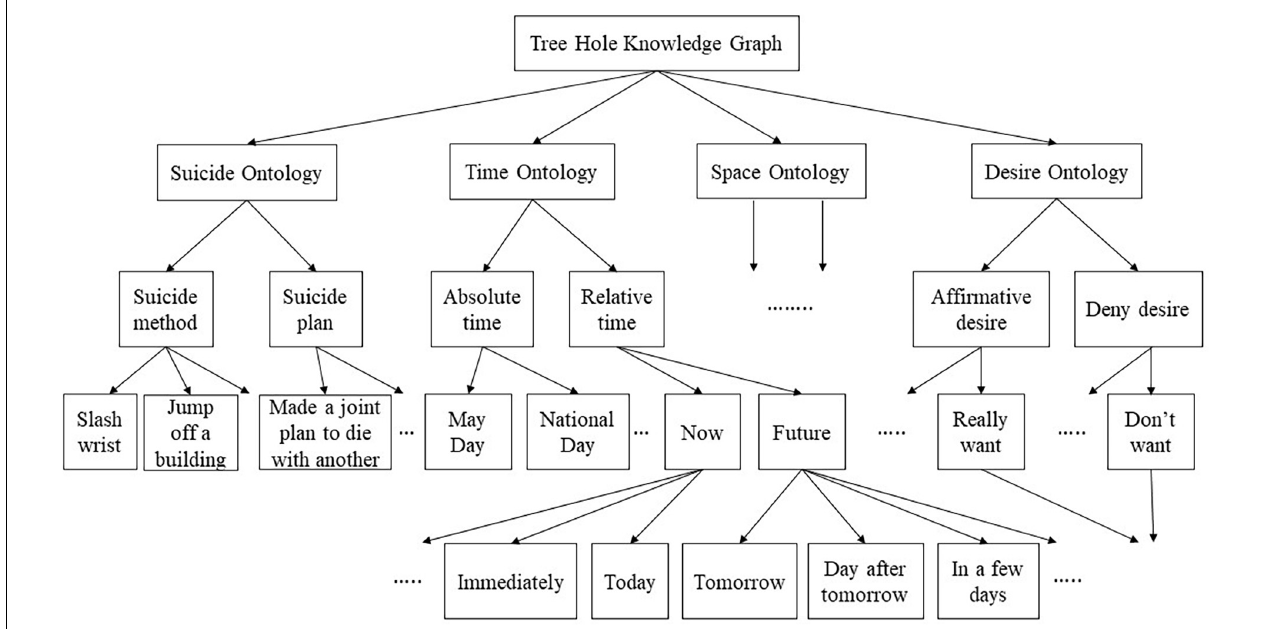
FIGURE 1 | “Tree Hole Knowledge Graph” (Huang et al.,